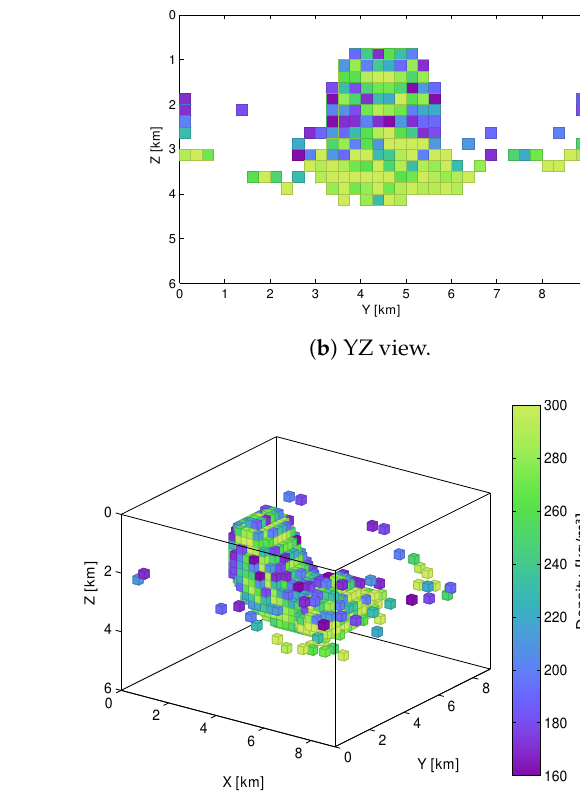
( d ) Three-dimensional view.